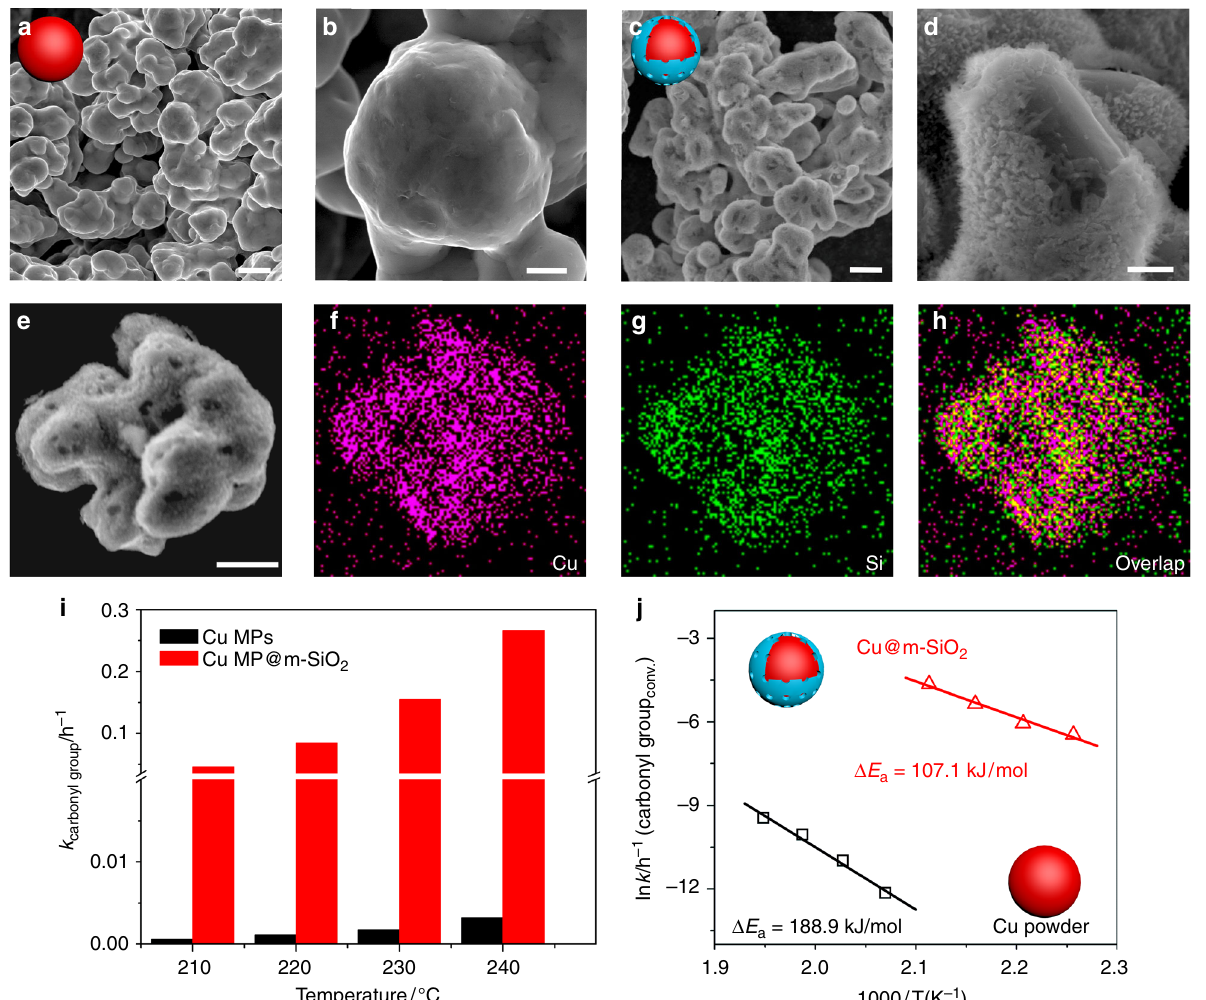
Fig. 1 Demonstration of Cu – O – SiO X interface effect in DMO hydrogenation. a – d SEM images of Cu microparticle before ( a , b ) and after ( c , d ) coating mesoporous silica; e – h EDX mapping images of mesoporous silica coated Cu microparticles (Cu@m-SiO 2 ); i , j Catalytic performance and the